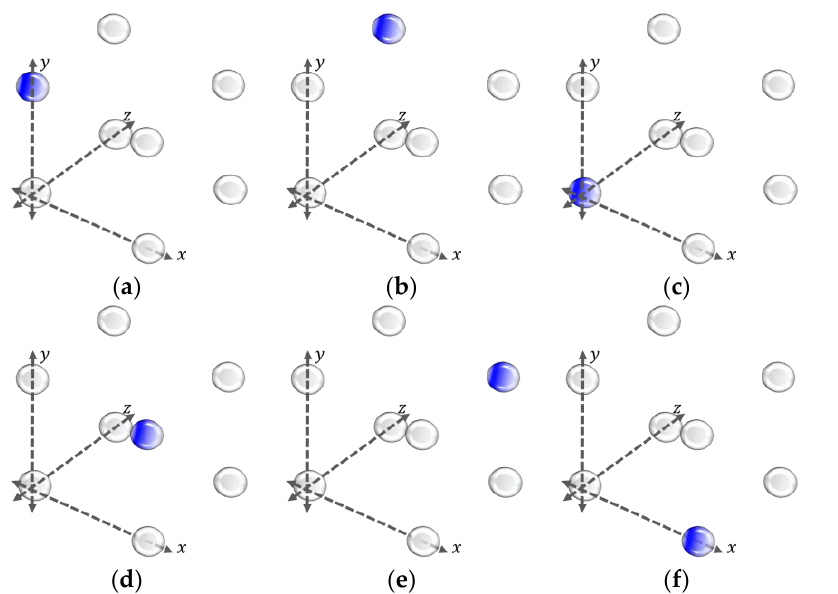
Figure 10. Classification of positions where virtual objects are generated (six types): ( a ) left side; ( b ) top side; ( c ) front side; ( d ) right side; ( e ) bottom side; ( f ) back side.